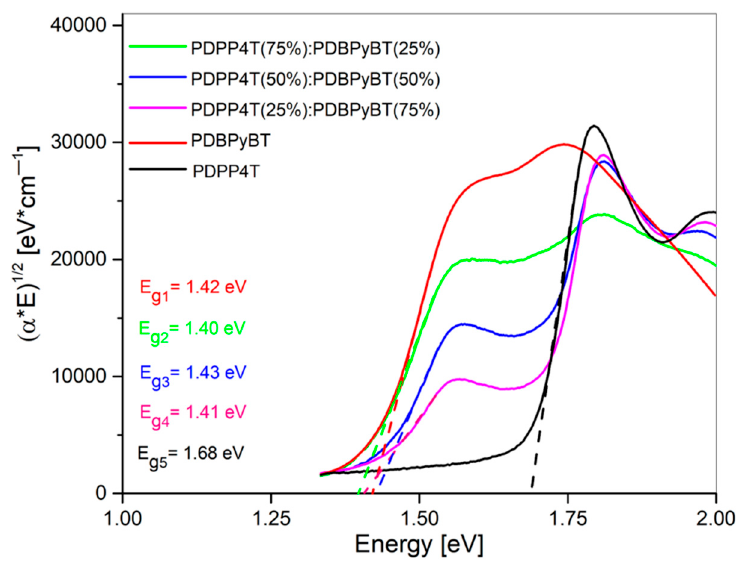
Figure 4. Bandgap Eg determination for PDPP4T, PDBPyBT and its mixtures.